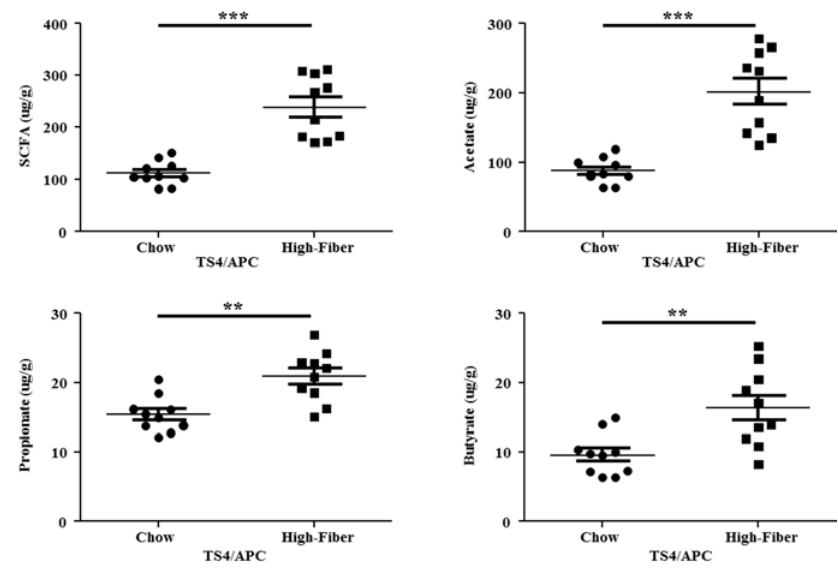
Figure 6. Significant changes in all short-chain fatty acids’ (SCFAs) metabolite levels, when examined in the entire cohort of TS4/APC chow-fed and high fiber-fed mice. Total SCFA concentration (MWU; p < 0.0001), acetic acid (MWU; p < 0.0001), propionic acid ( p = 0.0011), and butyric acid ( p = 0.0034) were all significantly increased in fecal samples of high fiber-fed mice compared to chow-fed mice. Mice ( n = 10) per group. Table 1. Significant correlations comparing microbiota and SCFA concentrations shown by TS4/APC ad libitum high fiber-fed